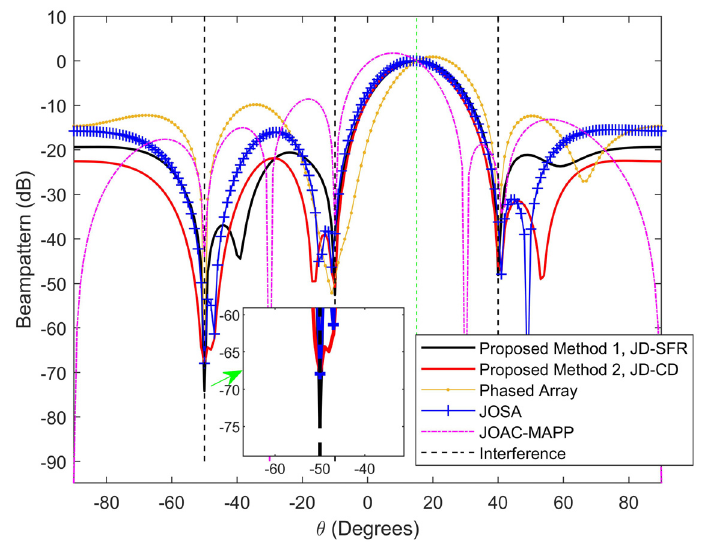
Figure 3. Compare the beampattern of the proposed method and other methods from three different interference azimuth angles at [ − 50 ◦ , − 10 ◦ ,40 ◦ ].